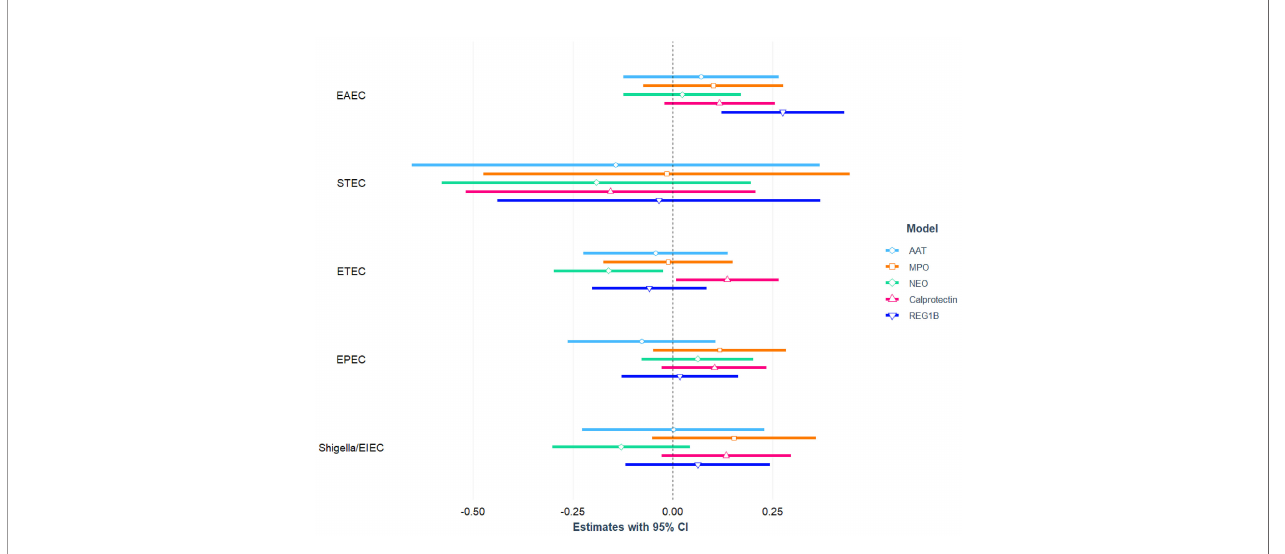
FIGURE 2 | Association between E. coli pathotypes and fecal biomarkers of EED in